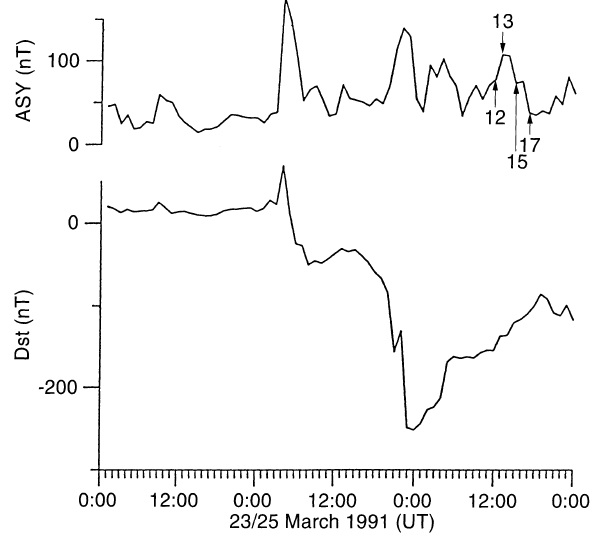
Fig. 4. Dst and ASY values of the geomagnetic X -component on 23– 25 March 1991